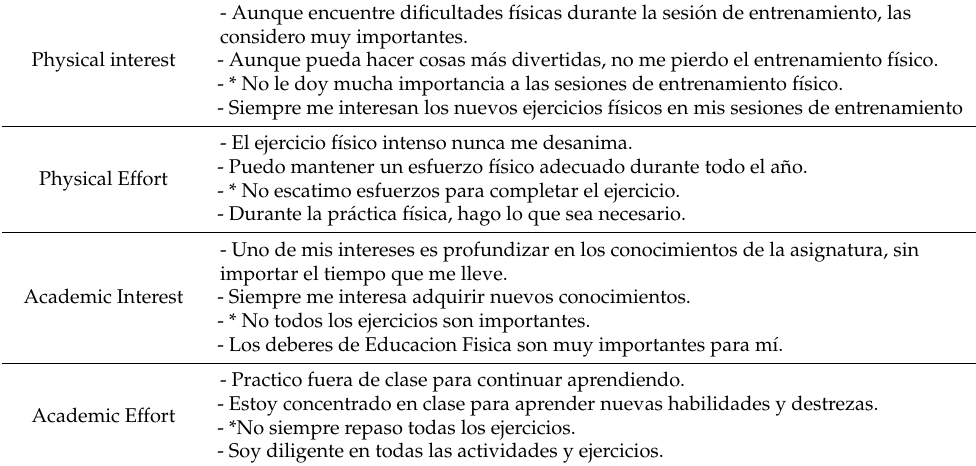
Table A1. The instrument was validated in